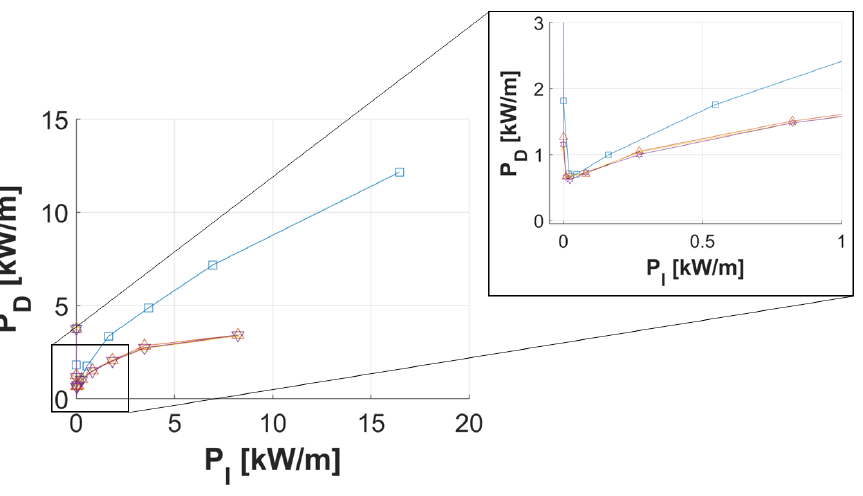
Figure 11. Dissipated power, P D , against injection power, P I , for constant ( (cid:3) ) [19] and pulsating base bleeds at 100 Hz ( (cid:52) ), 150 Hz ( × ), and 200H z ( (cid:53)